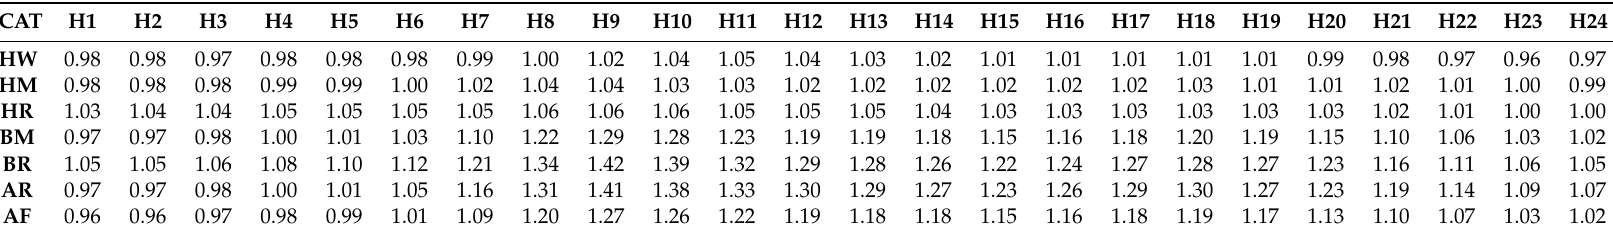
Table A4. Generic holidays and days before or after a